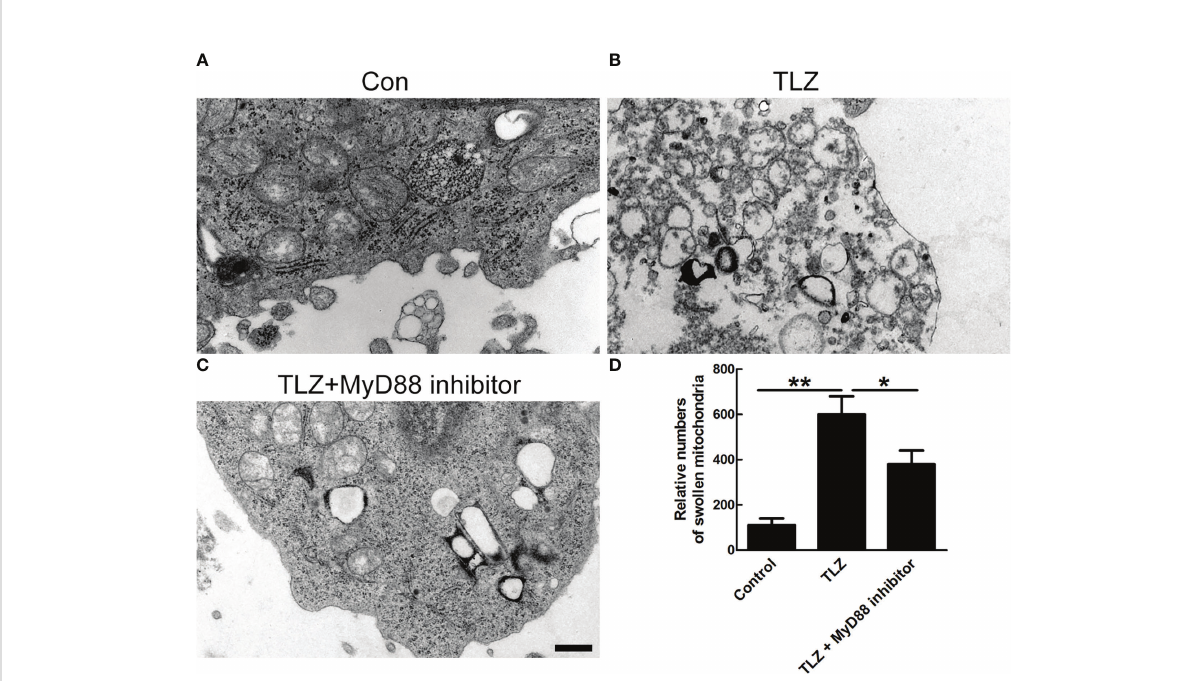
FIGURE 5 TEM photographs of ultrastructure of NP cells showing mitochondria. (A) Normal NP cells. (B, C) Normal NP cells under TLZ condition with or without MyD88 inhibitor. (D) Relative numbers of swollen mitochondria. *P < 0.05, **P < 0.01. N= 3 independent replicates. Bar = 1 m